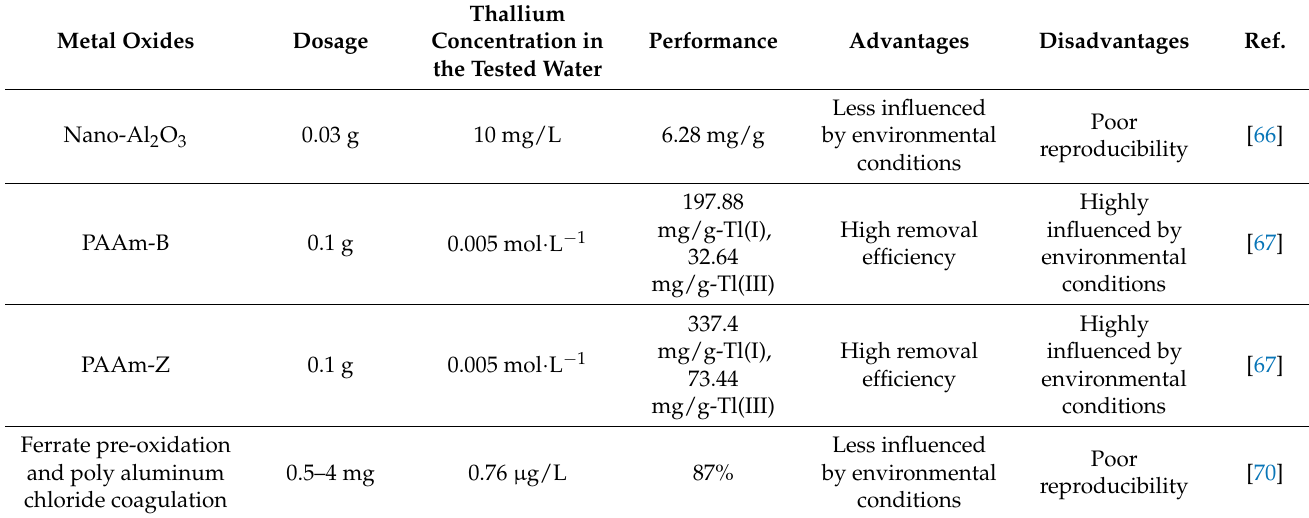
Table 3. Aluminum oxide removal thallium performance and advantages and